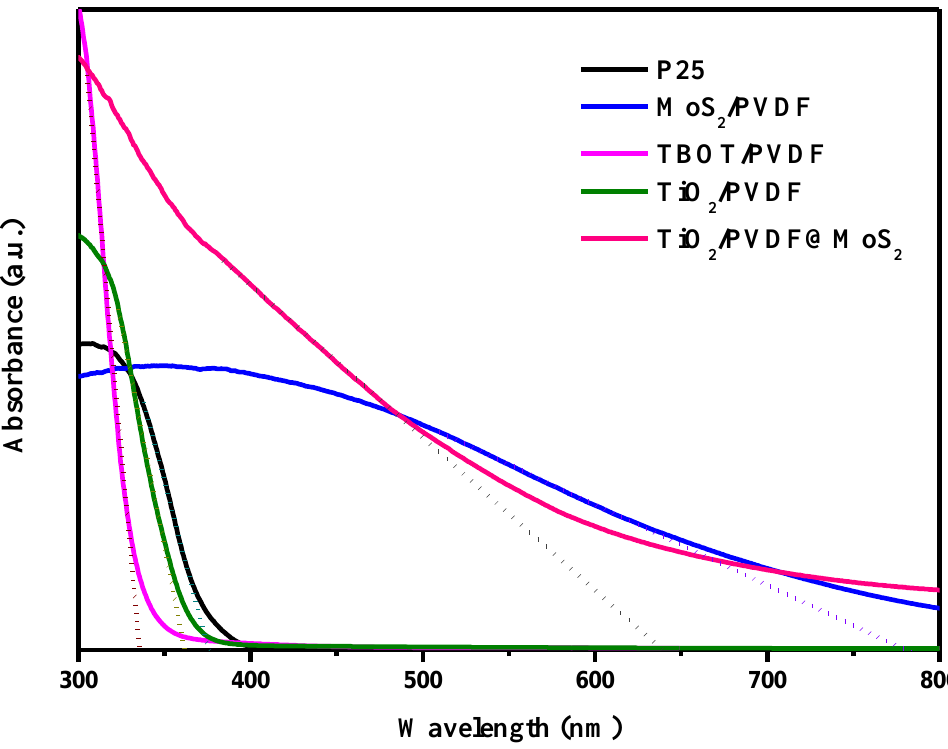
Figure 7. UV-vis diffuses reflectance spectra of different samples: P25, PVDF, MoS 2 /PVDF, TBOT/PVDF, TiO 2 /PVDF and TiO 2 /PVDF@MoS 2 . Table 1. The absorption edge and energy band gap for the typical